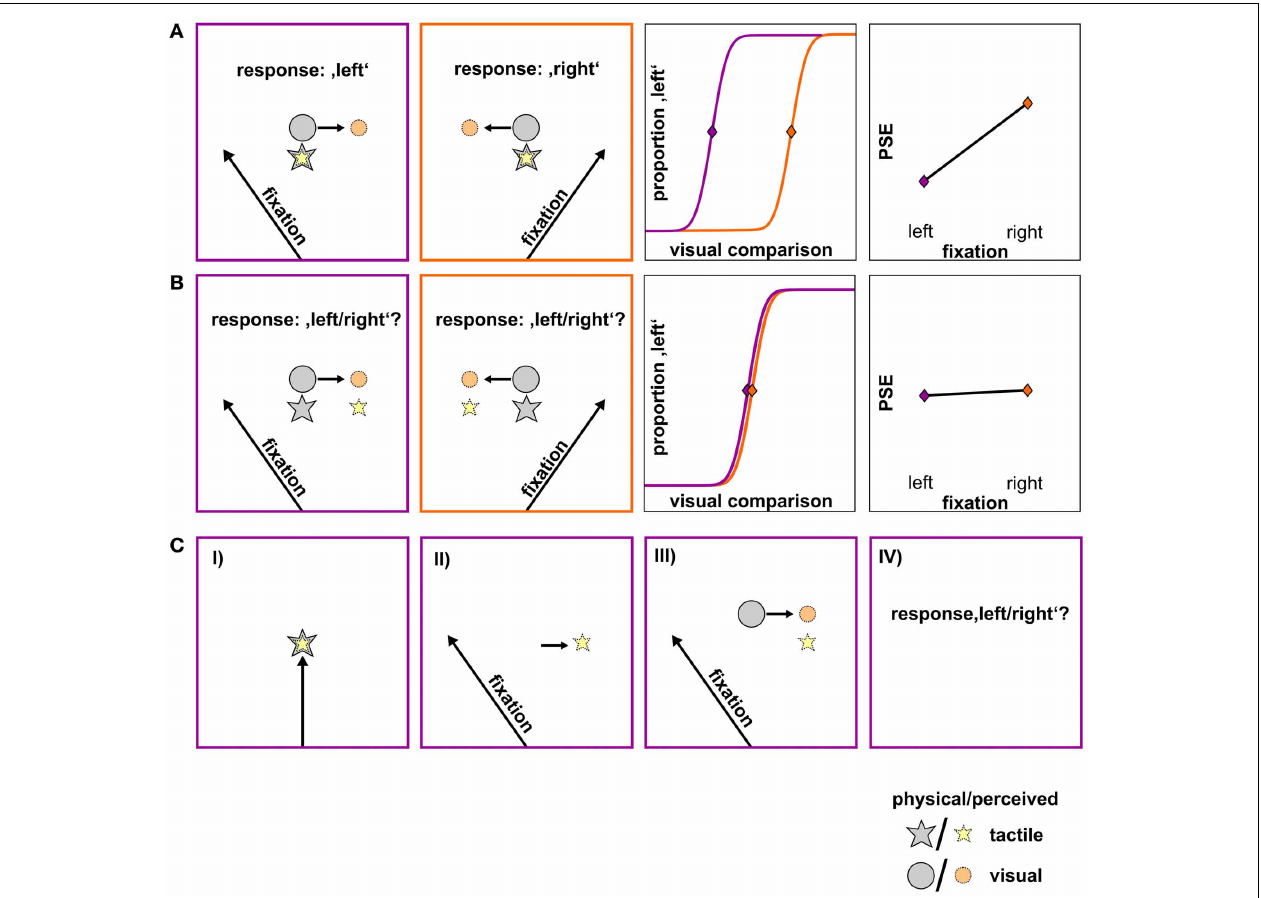
FIGURE 1 | Hypotheses on the influence of gaze direction on the spatial perception of the tactile and the visual stimulus, shown for a schematic standard-comparison combination. (A) Differential influence of gaze. Fixation to the left or to the right of the stimuli causes the visual stimulus to be misestimated opposite to gaze direction (orange circle) while the tactile stimulus remains unaffected by gaze direction (yellow star). Consequently, the same spatial relation between the physical tactile (gray star) and the physical visual stimulus (gray circle) results in a perceived spatial relation (colored star/circle) that varies as a function of fixation (1st and 2nd panel). For a specific standard location to be perceived as aligned to a visual comparison, the visual comparison has to be presented more leftwards when the fixation is left and more rightwards when the fixation is right. This is reflected in a shift of psychometric functions and thus on PSEs depending on